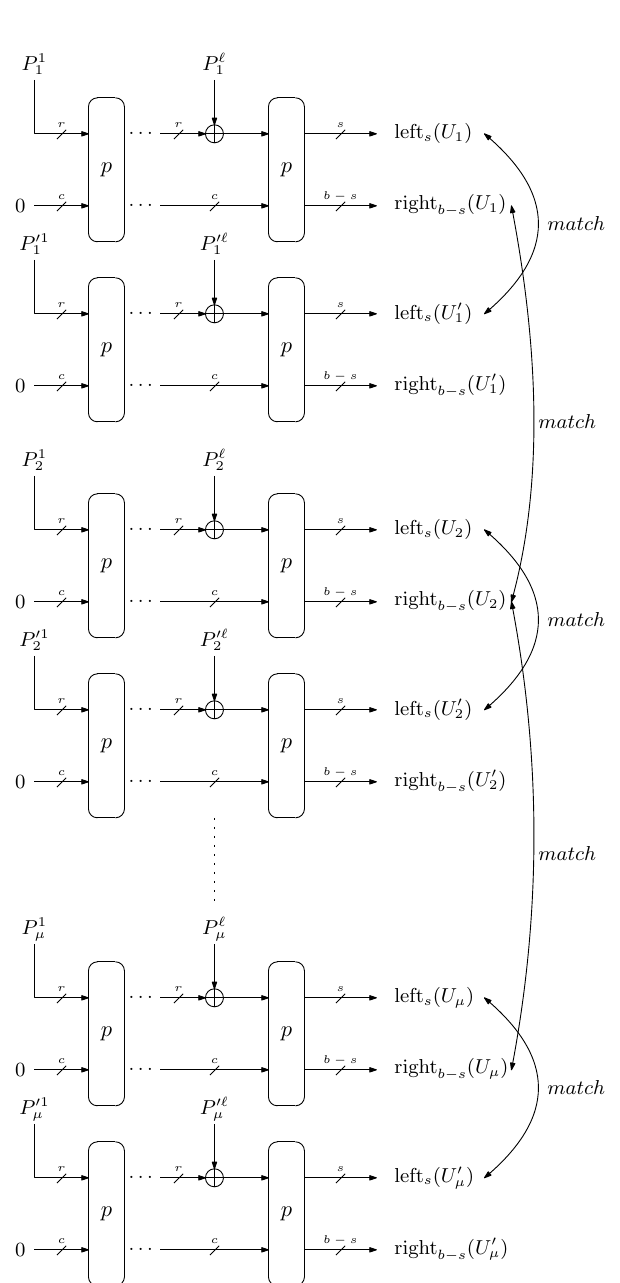
Figure 2: Visualization of the required collision structure. Here, plaintexts P 1 , . . . , P µ are all distinct, and P 0 6 = P i for each i i